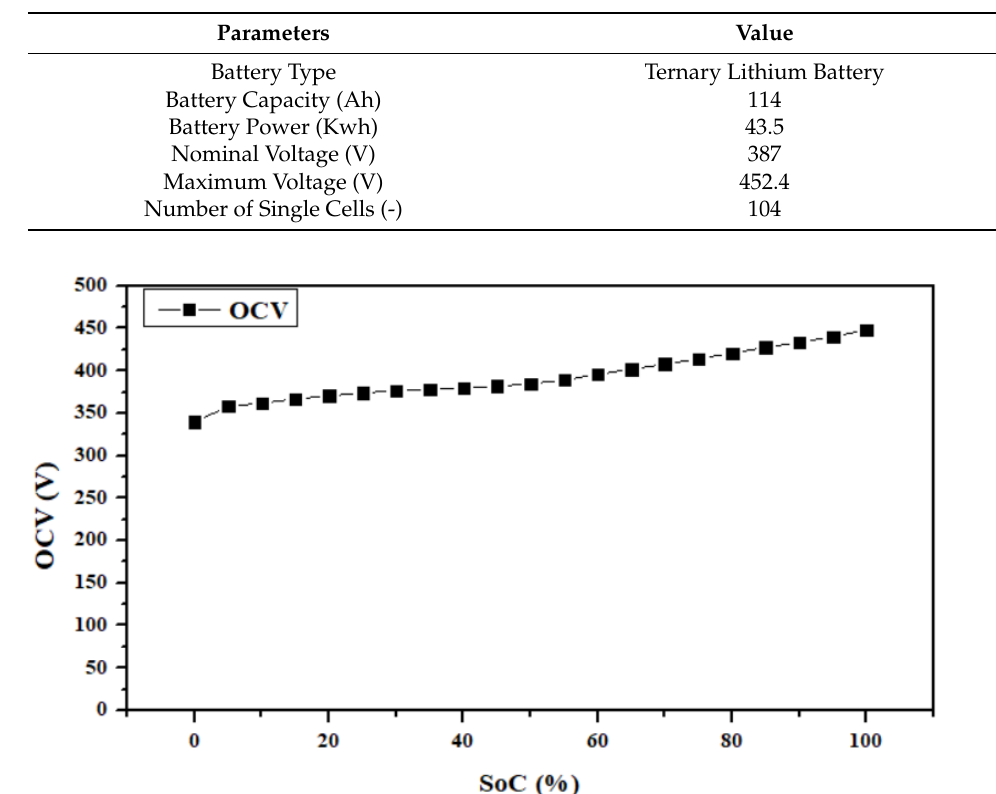
Figure 4. SoC–OCV curve of the studied battery. Figure 4. SoC – OCV curve of the studied battery.